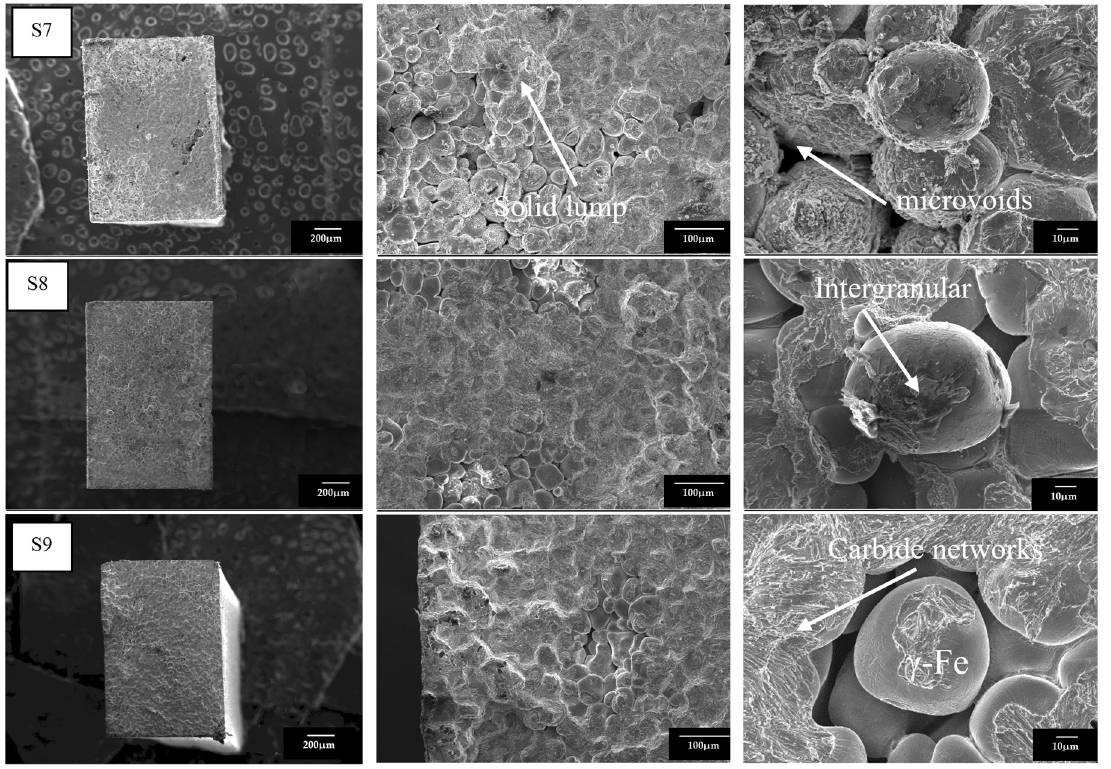
Figure 13. Fractured surface of welded joints of samples processed at various conditions: ( S7 ) 1300 °C/0 min, ( S8 ) 1300 °C/5 min, ( S9 ) 1300 °C/10 min.